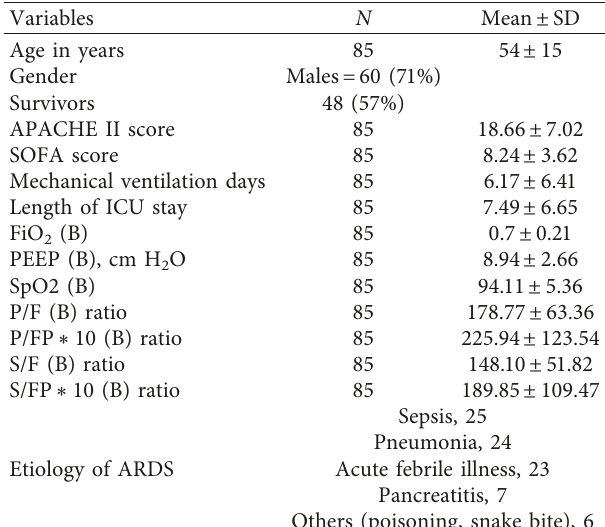
Table 1: Depiction of the mean and standard deviation of the demographic and baseline variables in 85